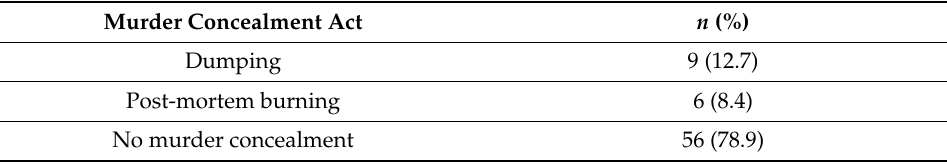
Table 2. Murder concealment acts performed by the